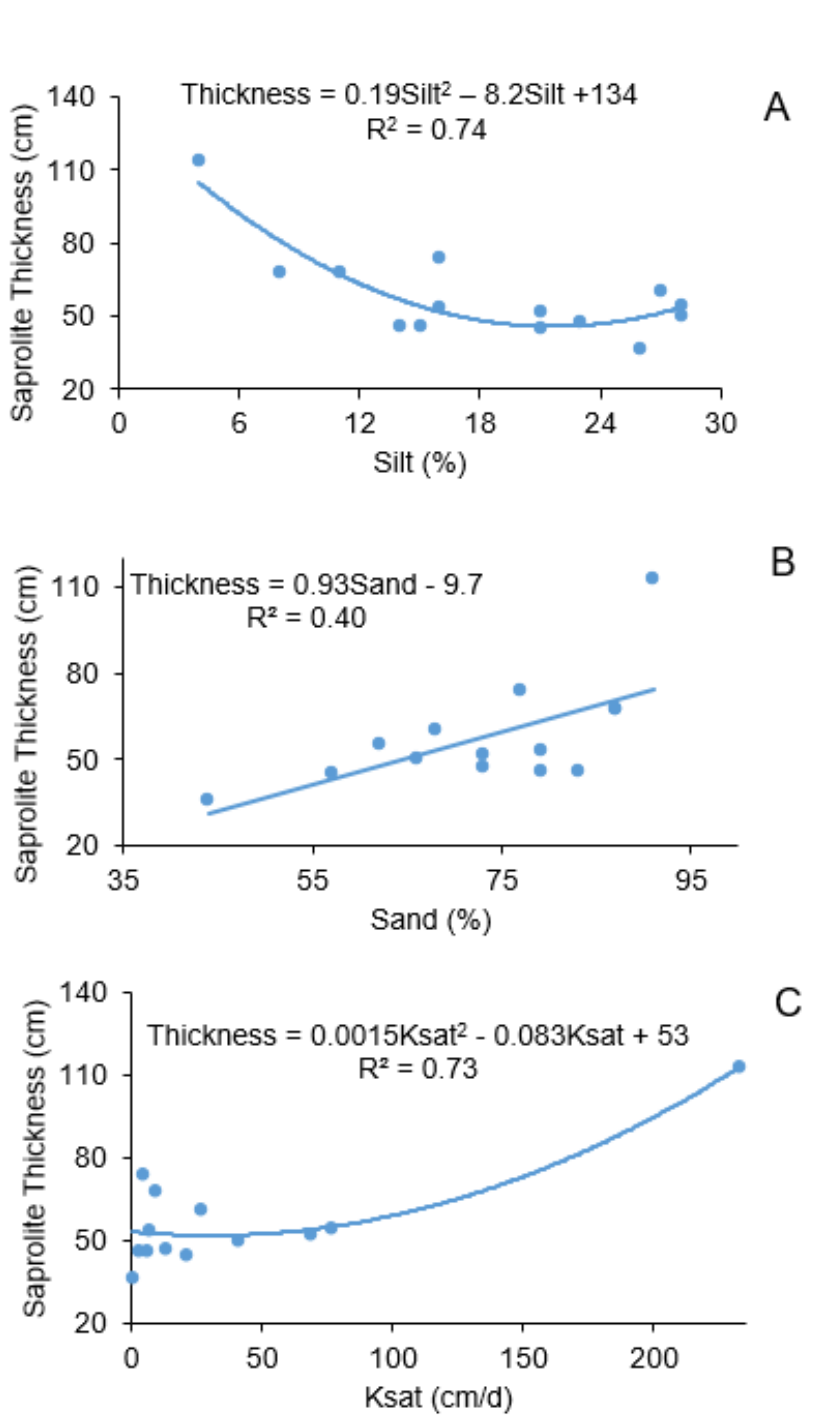
Figure 2. Relationships between ( A ) silt percentage, ( B ) sand percentage, and ( C ) saturated hydraulic conductivity (K sat ) and saprolite thickness needed to filter E. coli.